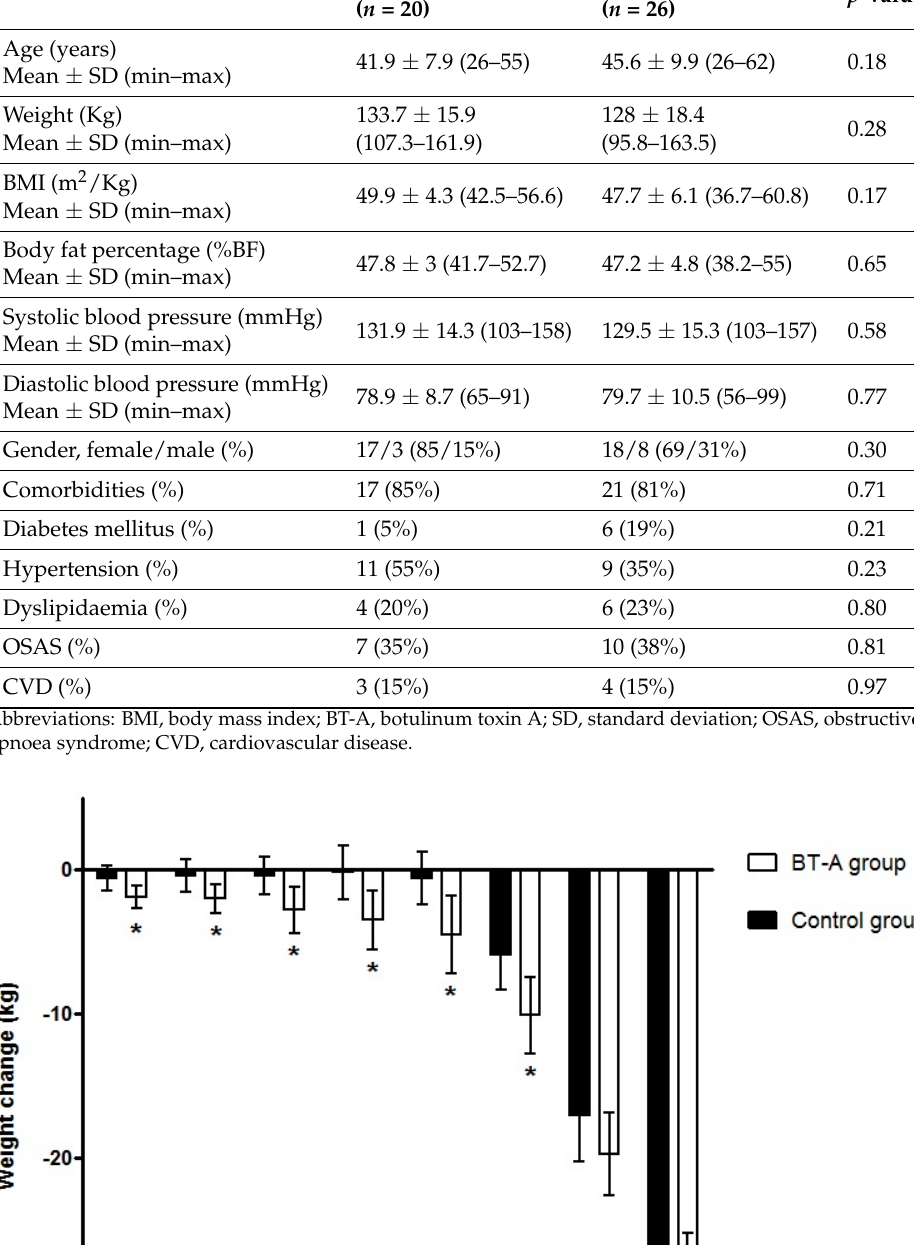
Table 1. Baseline characteristics: comparison between groups.